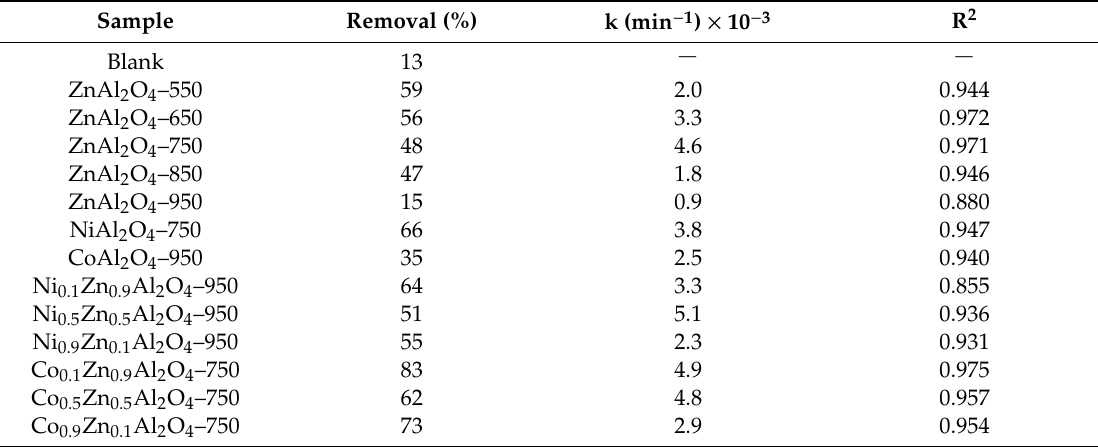
Table 4. Degradation rate constant (k) and rhodamine B dye removal